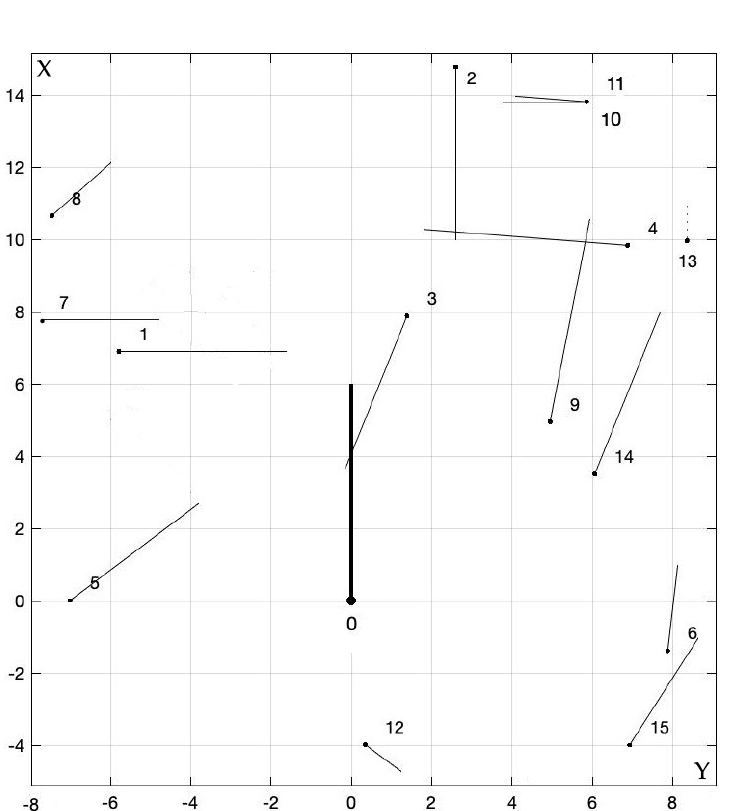
Figure 7. Visualization of the navigation situation in the Skagerrak Strait in the form of 18 min vectors denoting the speeds of the considered ship and the 15 met ships.